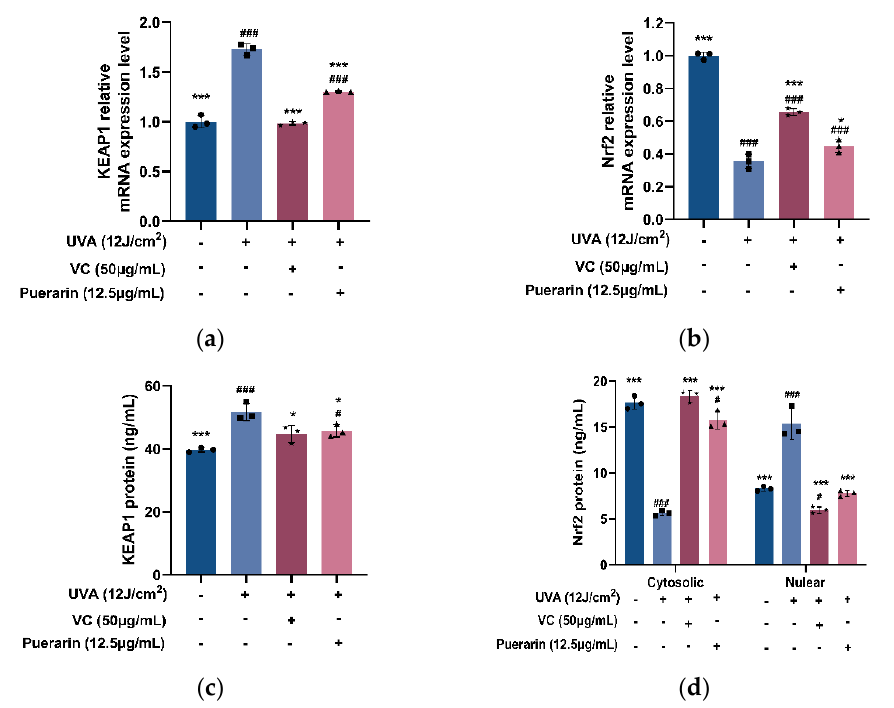
Figure 3. Effects of puerarin on UVA-induced Nrf2 signaling in HSF: ( a , b ) RT-PCR analysis of KEAP1 and NRF2 expression levels; ( c , d ) ELISA analysis of KEAP1 proteins and Nrf2 proteins in nucleus and cytosol. # p < 0.05, ### p < 0.001 as compared to the control group; * p < 0.05, *** p < 0.001 as compared to the damage model group; Values do not have a common mark ( # , *) when p > 0.05, ( n = 3).